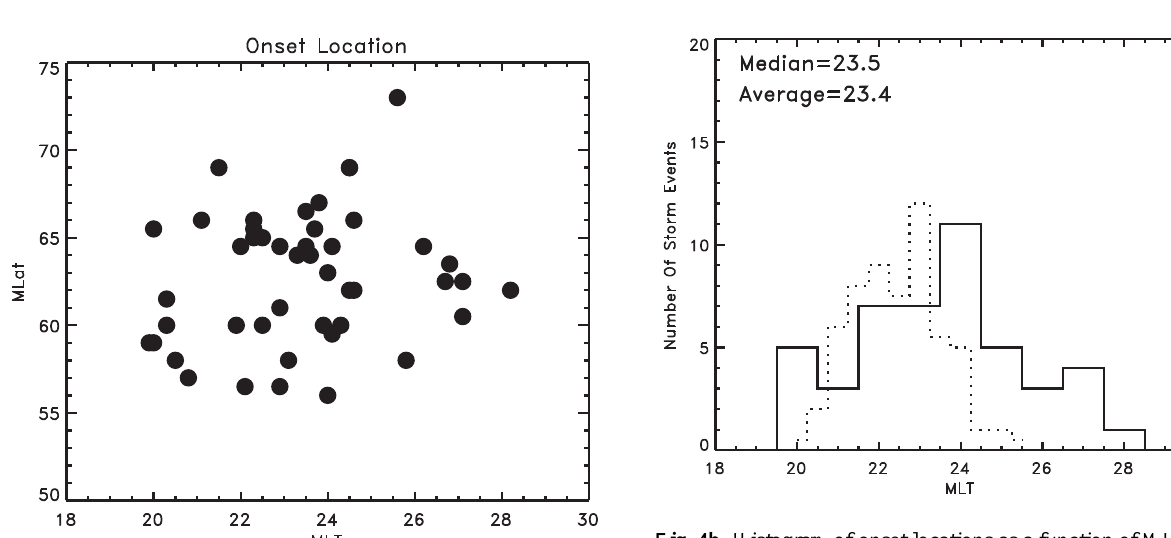
Fig. 4b. Histogram of onset locations as a function of MLT. Super- imposed is a similar histogram for isolated substorms (from Gjer- loev et al., 2007).